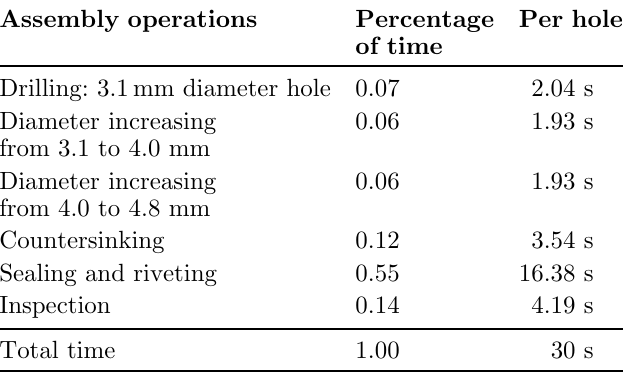
Table 2. Time estimated for automatic operations on a CFRP and thermoplastic compound panel with 1500 holes using 9 mm grip Hi-lite fasteners.